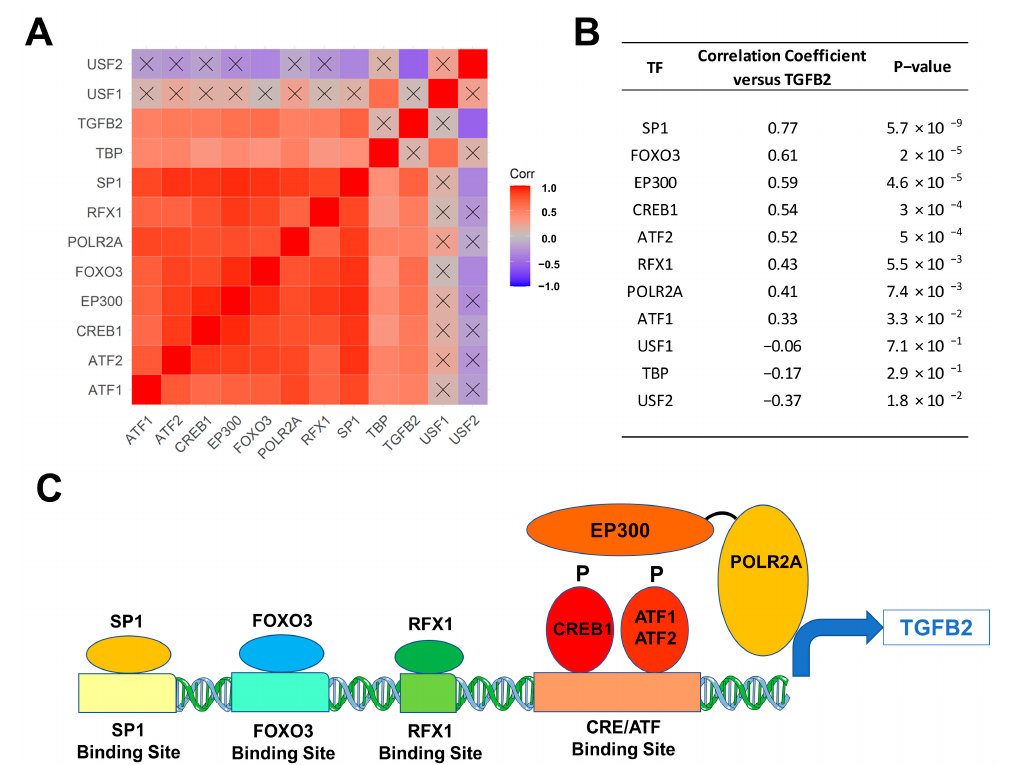
Figure 2. Correlation matrix of TGFB2 and transcription factors in 41 DIPG patients. Pairwise Pearson correlations were performed between the mRNA levels of TGFB2 and 11 transcription factors using log 2 -transformed TPM values obtained from cBioPortal for Cancer Genomics (https://pedcbioportal.kidsfirstdrc.org/). The correlation coefficients were calculated across 41 DIPG patients, depicted on the heatmap ( A ) ranging from positive correlations (red) to negative correlations (blue) and organized according to similarly expressed genes. The scale for the range of correlations is shown in the color bar, “Corr”. Of the 66 pairwise correlations, 48 were deemed statistically significant ( p < 0.05 and FDR = 0.07; non-significant correlations are indicated with a black cross in the heat map). ( B ) The mRNA levels for 8 of 11 transcription factors (viz.: SP1, RFX1, POLR2A, FOXO3, EP300/transcription factor co-activator, CREB1, ATF2, and ATF1) exhibited statistically significant positive correlations with TGFB2 mRNA levels. SP1, FOXO3, and EP300 mRNA levels showed the most significant correlations with TGFB2 mRNA expression levels ( p < 0.0001). ( C ) Depicted in the cartoon figure are the transcription factor proteins (oval shapes) bound to binding sites on the TGFB2 gene for these transcription factors (rectangles). Additionally, indicated are the recruitment of the transcription factor co-activator EP300 (E1A Binding Protein P300), that binds to phosphorylated forms of CREB1/ATF1/ATF2 and the bridging to the basal transcription machinery via the RNA Polymerase II Subunit A (POLR2A) to directly stimulate TGFB2 transcription.